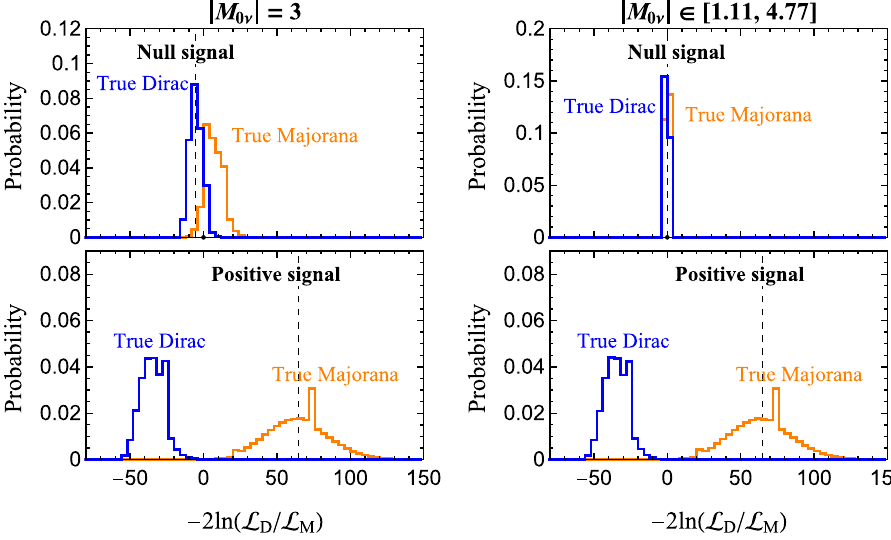
/ L ) while the lower half stands for the scenario where a positive excess of D M events has been observed (i.e., N exp tot − B > 0). The observed value of the test statistic is marked by the dashed vertical line. In the case of a positive excess, we assume the observed signal event number to be N exp tot − B ≈ 27 (can be read from Eq. (7)), which is the expecta- (cid:2) (cid:2) (cid:2) (cid:2) (cid:2) = 3, while in the right panel, the (cid:2) (cid:2) M (cid:2) M = 0 eV, ρ = 90 ◦ , and = 3. tion value by taking m (cid:2) (cid:2) true 0 ν 3 , true 0 ν true (cid:2) ∈ ( 1 . 11 , 4 . 77 ) during (cid:2) M The model parameters of pseudo-experiments for all the hypotheses are 0 ν located by maximizing the likelihood with respect to a null or positive signal